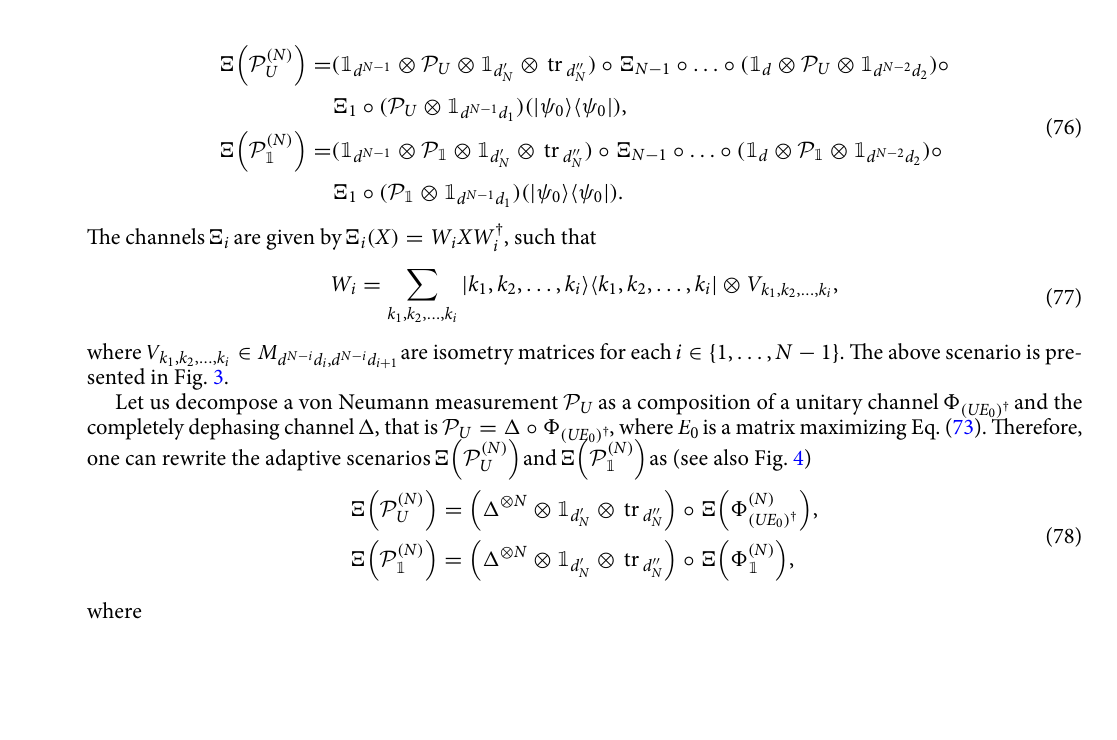
) is applied to N copies · (cid:31)